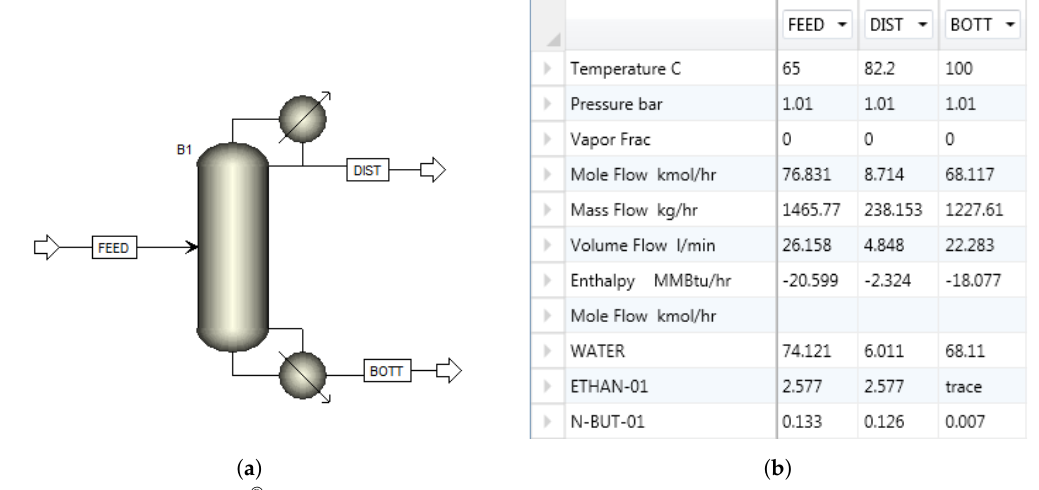
Figure 3. Aspen Plus ® screenshots of the flowsheet and overall stream table. ( a ) Flowsheet. ( b ) Stream